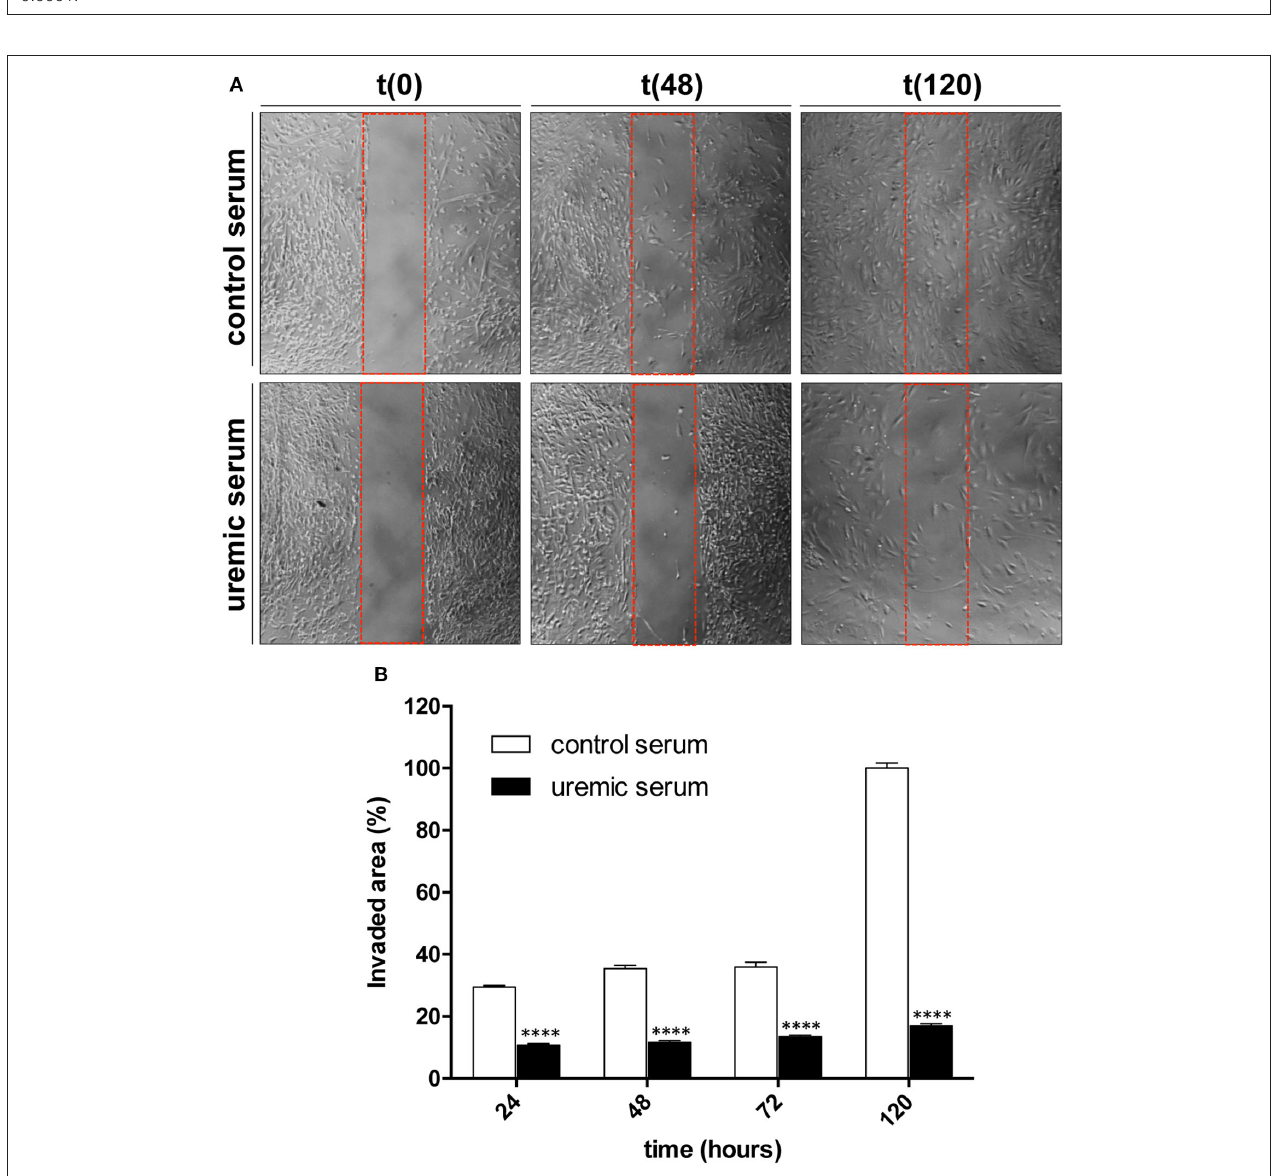
FIGURE 7 | Uremia decreases migration of cultured HASMC. (A) Cells were grown to confluence in 35mm dishes containing a silicon insert forming two chambers while treated with DMEM supplemented with control or uremic serum. After removal of the insert culture medium was changed to serum-free DMEM to prevent cell proliferation. Cells were then monitored and photographed at the indicated times with a phase-contrast microscope. (B) Values represent percentage of invaded area (mean ± SE, N = 3). Student’s t -test: **** P <